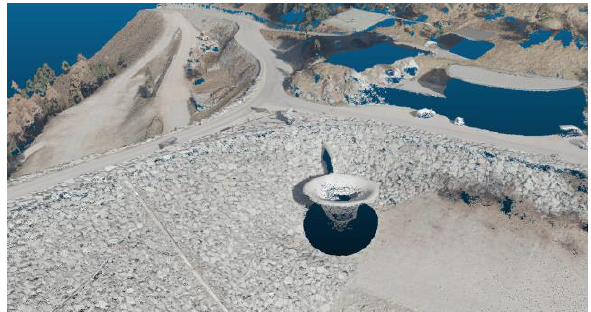
Figure 2. Example of the DIM point cloud around the dam with the overflow cone in the centre.